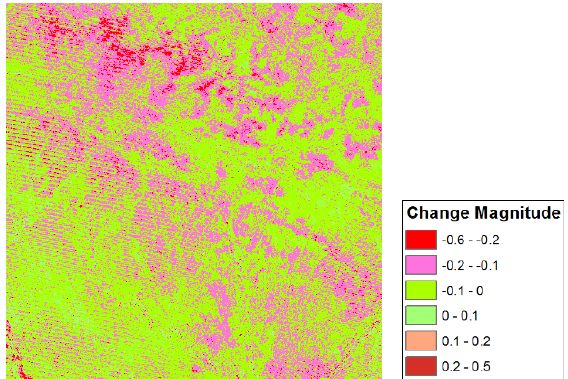
Figure 4. Change Magnitude from Bfast monitoring and legend The red area in figure 4 represents the area where change magnitude is higher and green area of the figure suggest lower change magnitude.